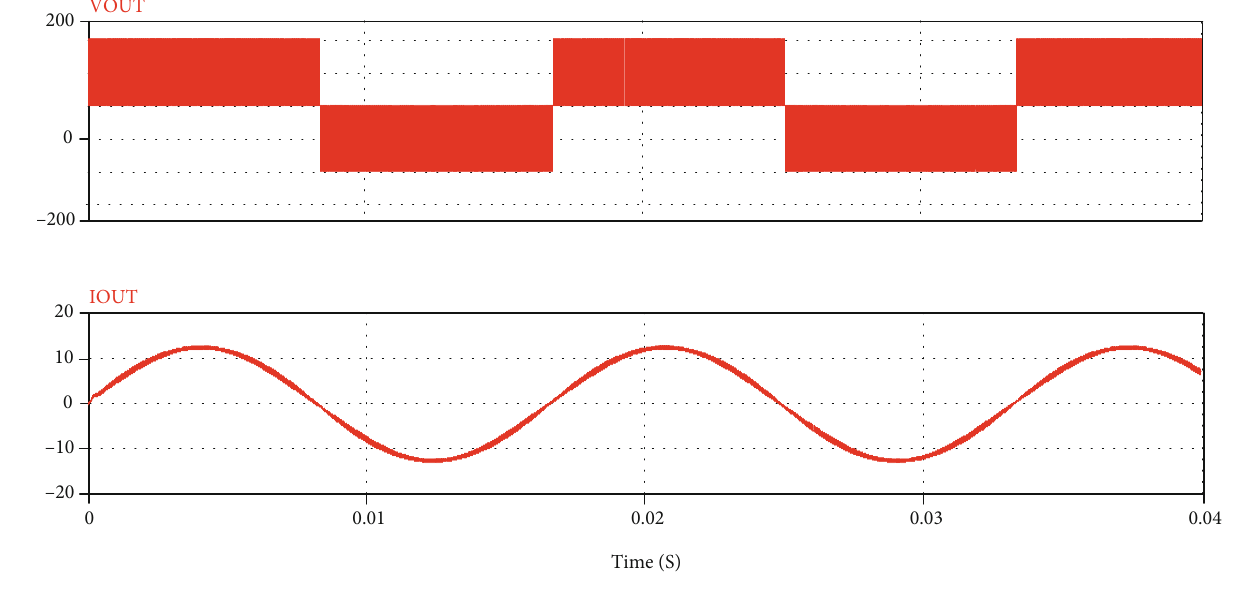
Figure 10: Inverter output voltage before fi lter. (a, b) Output voltage (100V/div) and output current (10 A/div).